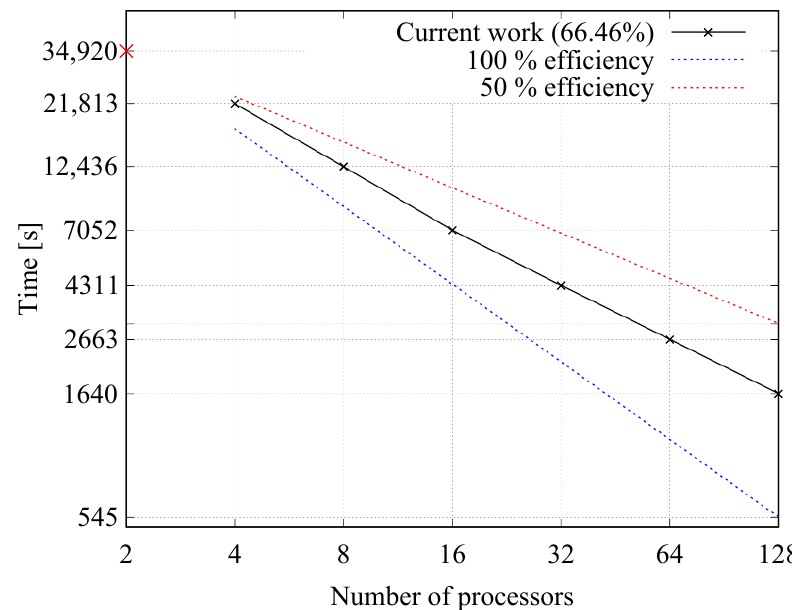
Figure 16. Strong scalability test up to 128